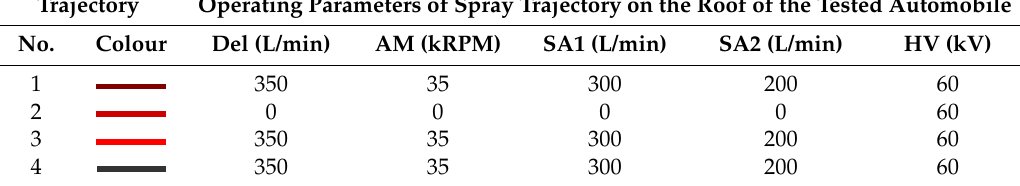
Table 1. Operating parameters of spray trajectory on the roof. Table 2. Operating parameters of spray trajectory on the side.